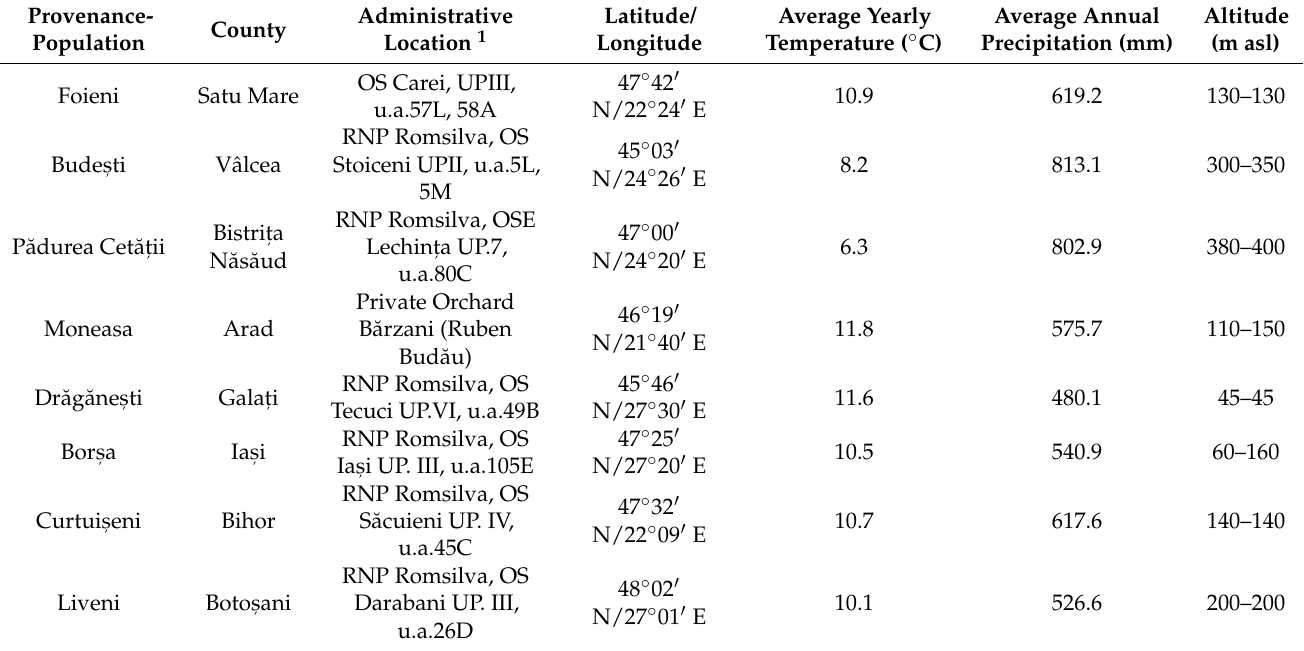
Table 1. Location and climatic characteristics of the eight R. pseudoacacia seeds provenances in